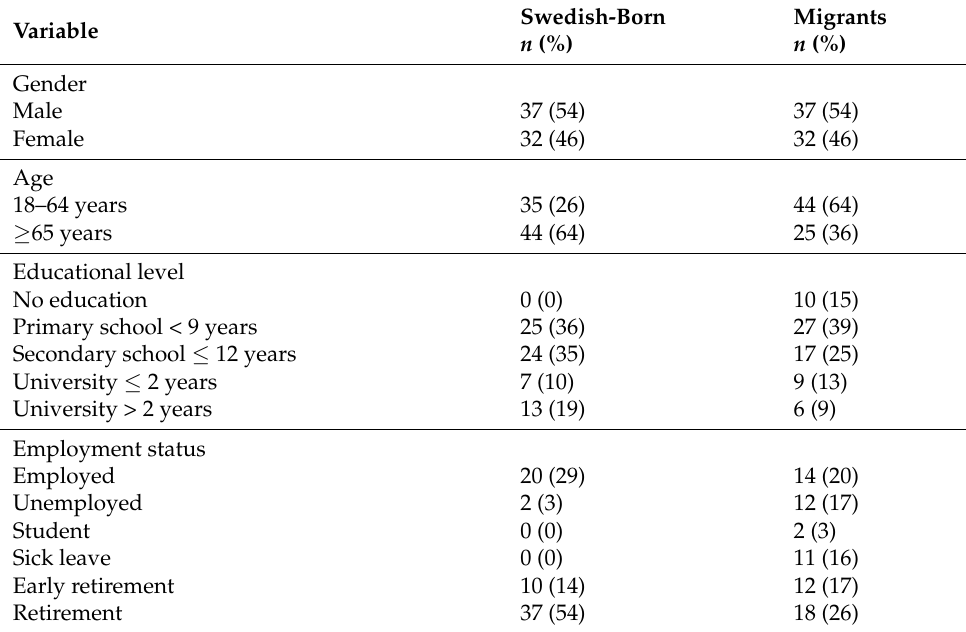
Table 1. Characteristics of the study